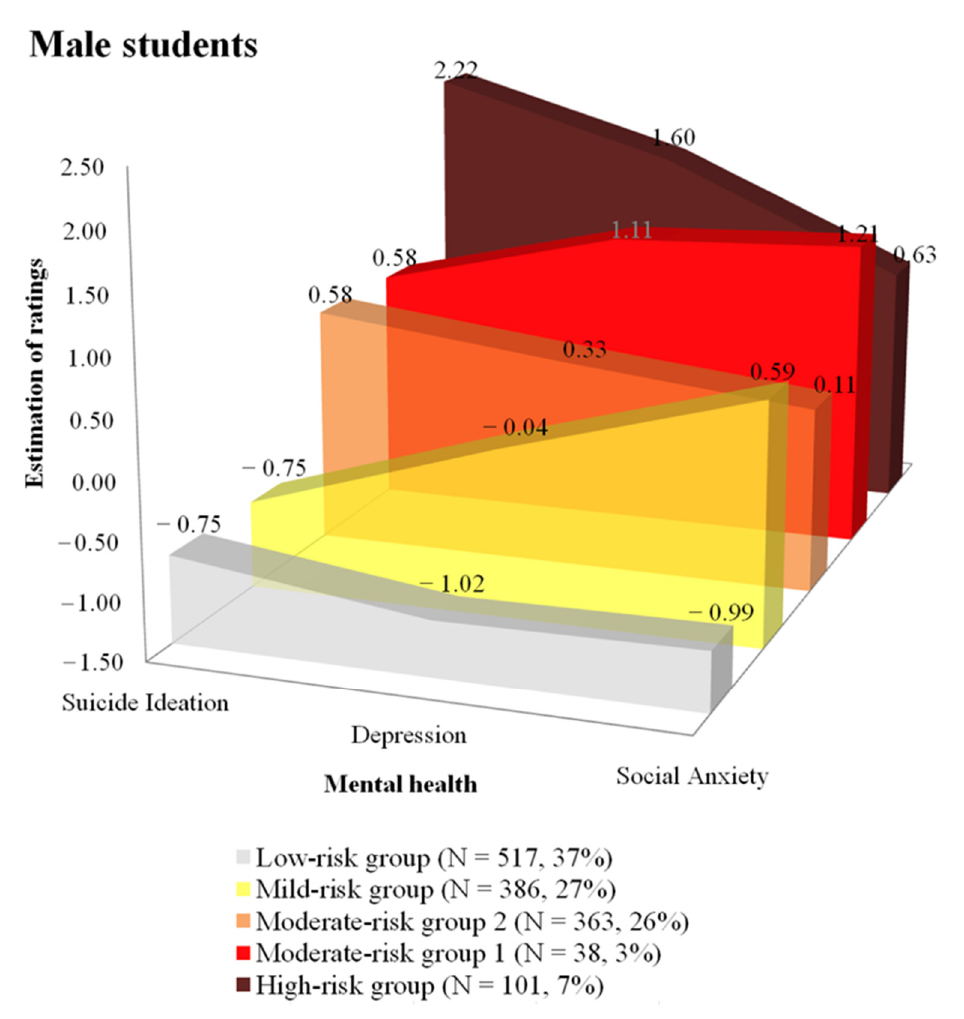
Figure 1. Five profiles in the mental health of Korean male youth.